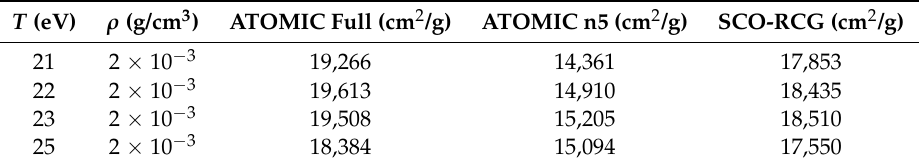
Table 2. Rosseland mean opacities computed with two versions of ATOMIC and SCO-RCG codes at conditions that can be reached experimentally on a laser facility. These conditions are interesting since they provide an average ionization close to the one of real stellar